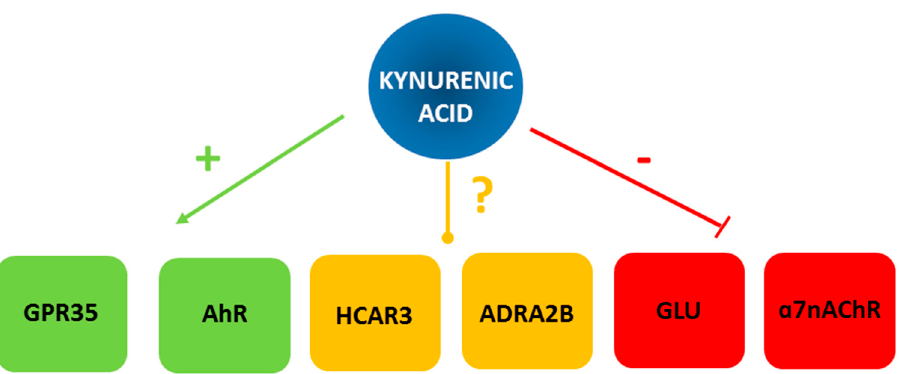
Figure 1. Graphical presentation of molecular targets of kynurenic acid. ADRA2B—adrenoceptor alpha 2B; AhR—aryl hydrocarbon receptor; GPR35—G protein-coupled receptor 35; GLU—glutamate receptor group; HCAR3—hydroxycarboxylic acid receptor 3; α 7nAChR—alpha-7 nicotinic acetylcholine receptor; (+)—agonist; ( − ) antagonist; (?)—putative ligand.